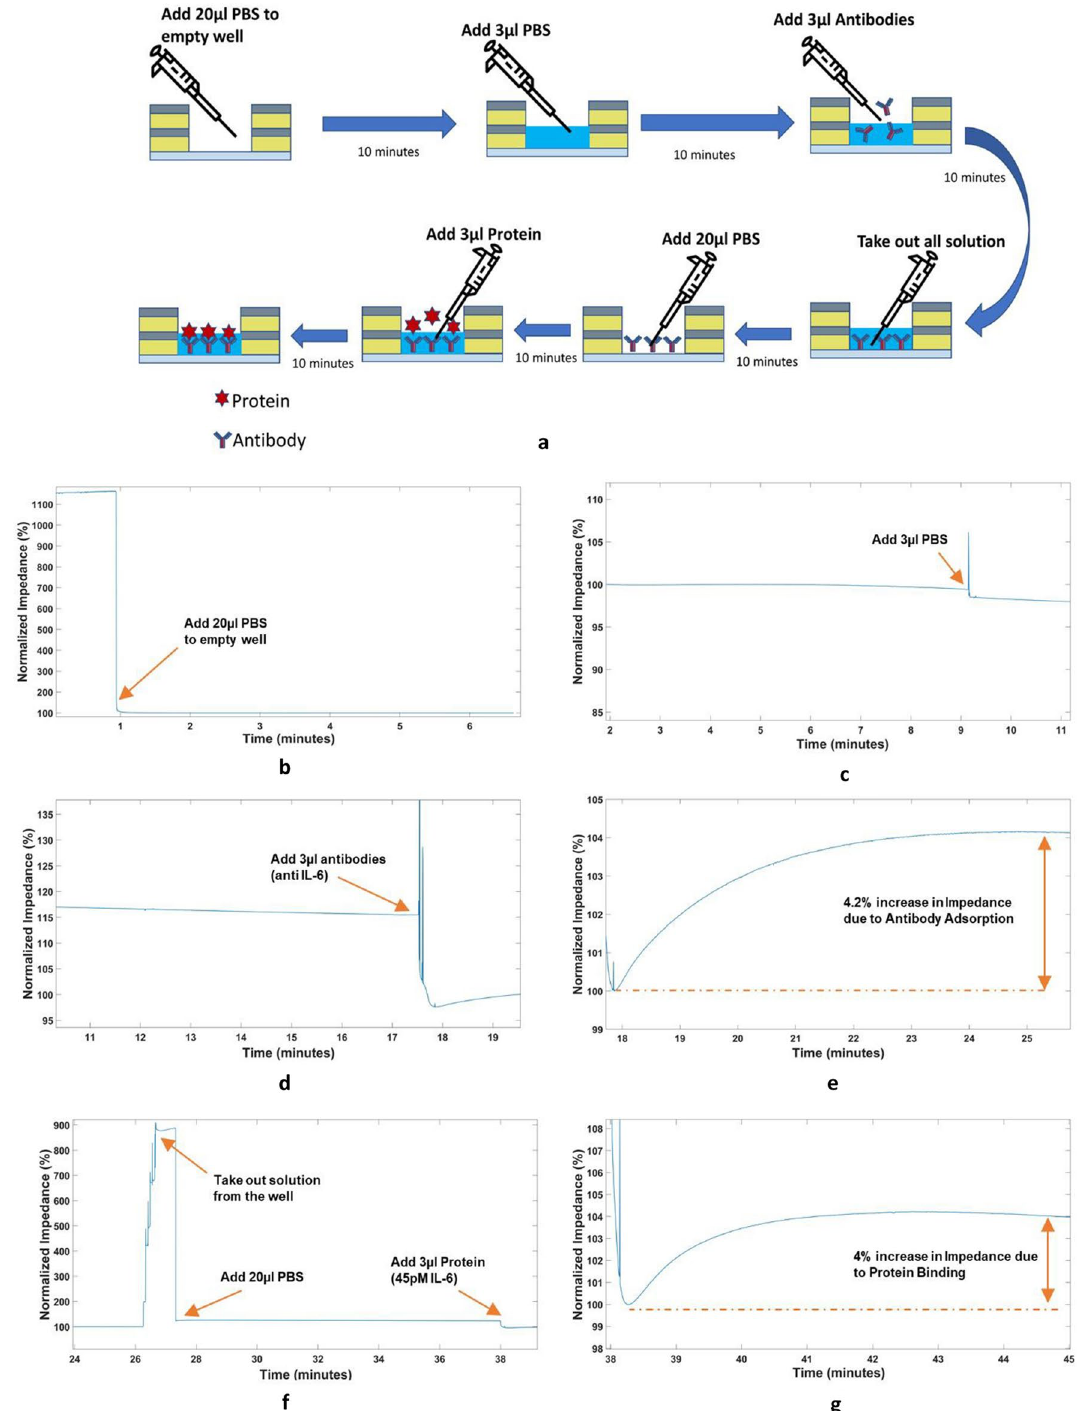
Figure 4. Protein Detection Experiment ( a ) Process Diagram for the experimental protocol used ( b ) Adding 20 μl PBS to an empty nanowell sensor ( c ) Adding 3 μl PBS to the sensor ( d ) Adding antibodies to the sensor ( e ) Approximately 4.2% increase in impedance due to antibody adsorption ( f ) Clearing the nanowell sensor by pipetting out solution and adding 20 μl PBS before adding 3 μl of 45 pM protein ( g ) Approximately 4% change in impedance observed due to protein